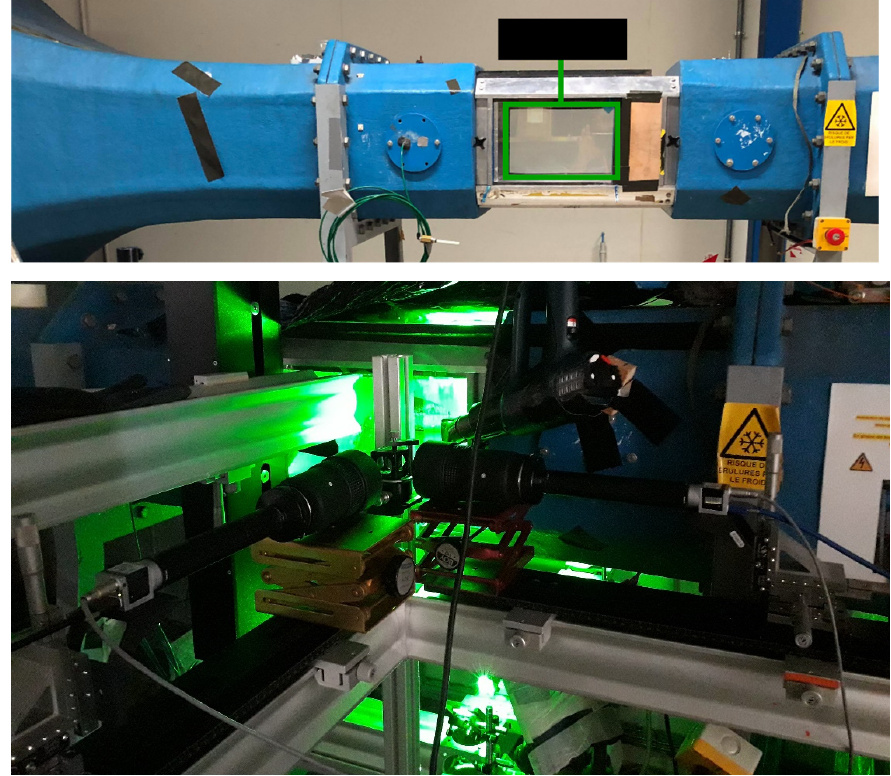
Figure 1. The icing tunnel: without experiment ( top ), with the measurement set-up ( bottom ).